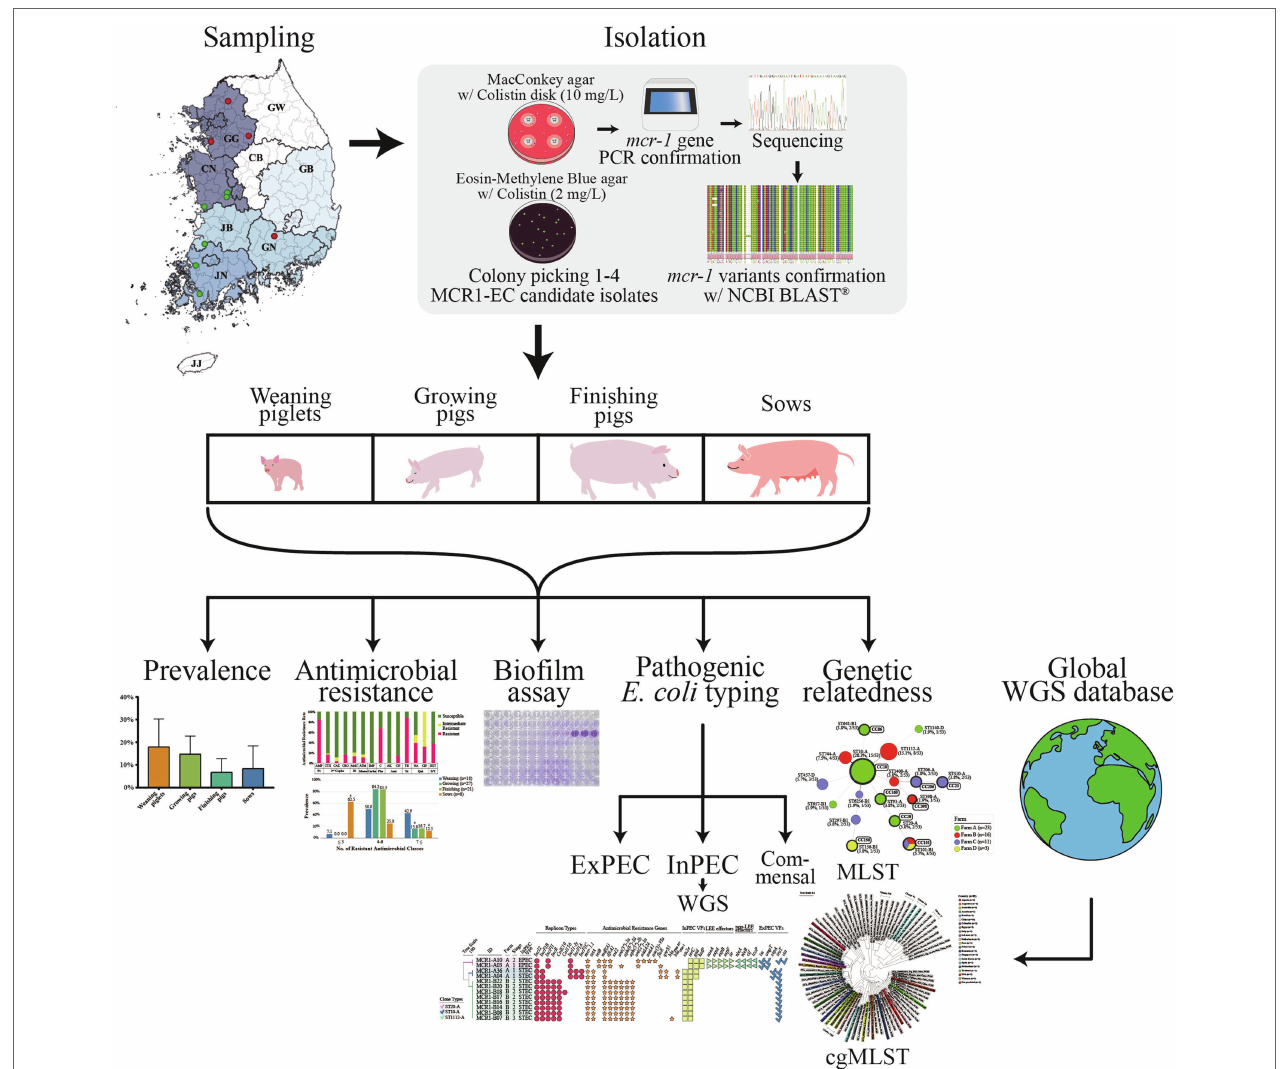
FIGURE 1 | Flow chart of the present study